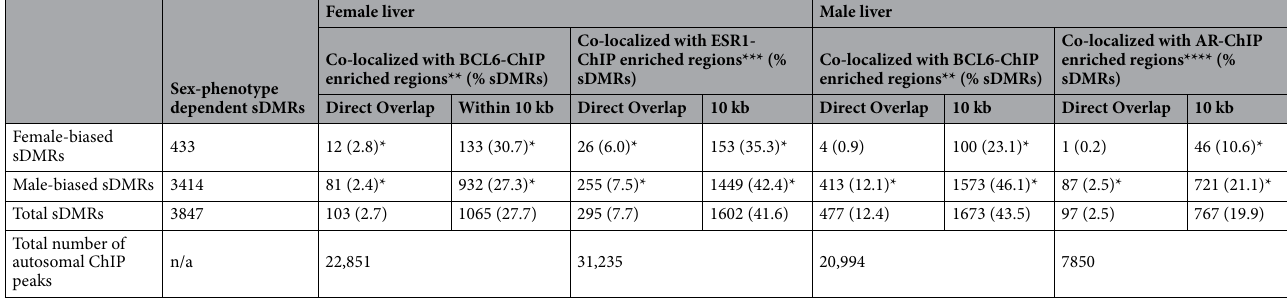
Table 1. Co-localization of autosomal sDMRs with BCL6, AR, or ESR1-enriched regions. *Statistical significance of co-localization of female-biased or male-biased sDMRs with TF-enrichment was determined by comparing the co-localization of 500 permutations with ChIP peaks. Asterisks indicate statistically significant results. **BCL6-ChIP peaks in female and male livers extracted from GSE31578- GSM784032, GSM784028 replicates 3 and 2, respectively; ***ESR1-ChIP peaks in female liver extracted from GSE32244; ****AR-ChIP peaks in male liver extracted from